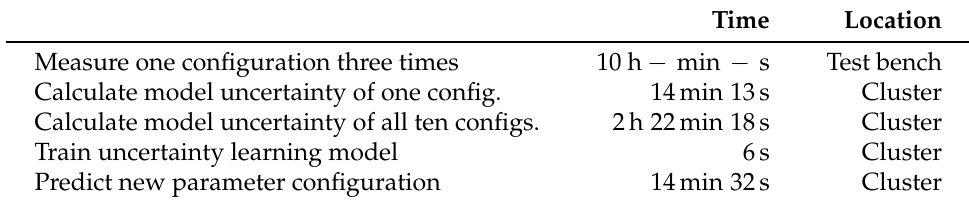
Table 4. Time needed to measure the parameter configurations on the roller dynamometer and to calculate them on a cluster with 40 Intel Xeon Processors at